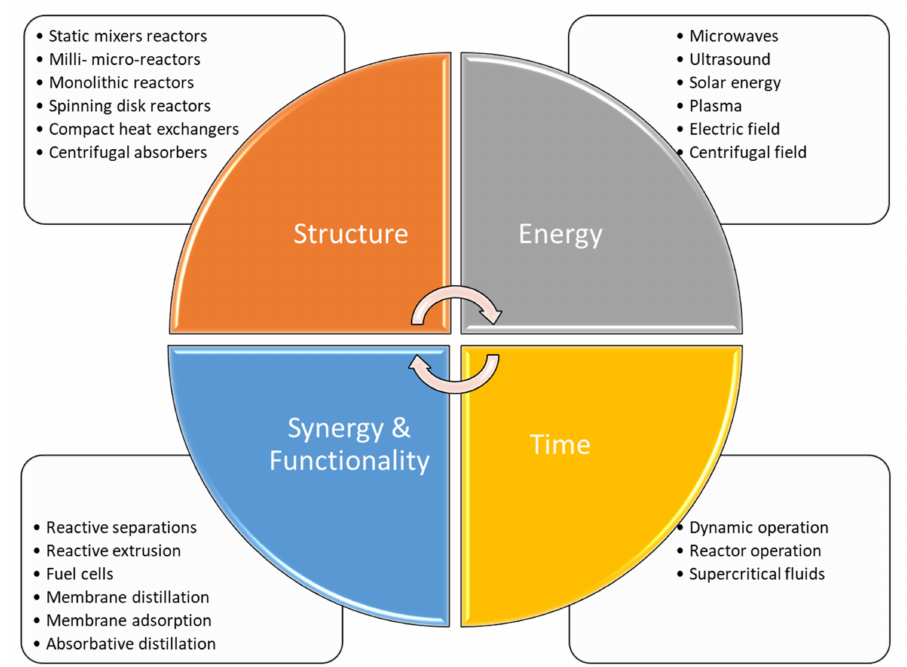
Figure 1. Principles of Process Intensification: definition of the main concepts of PI with application examples, adopted from